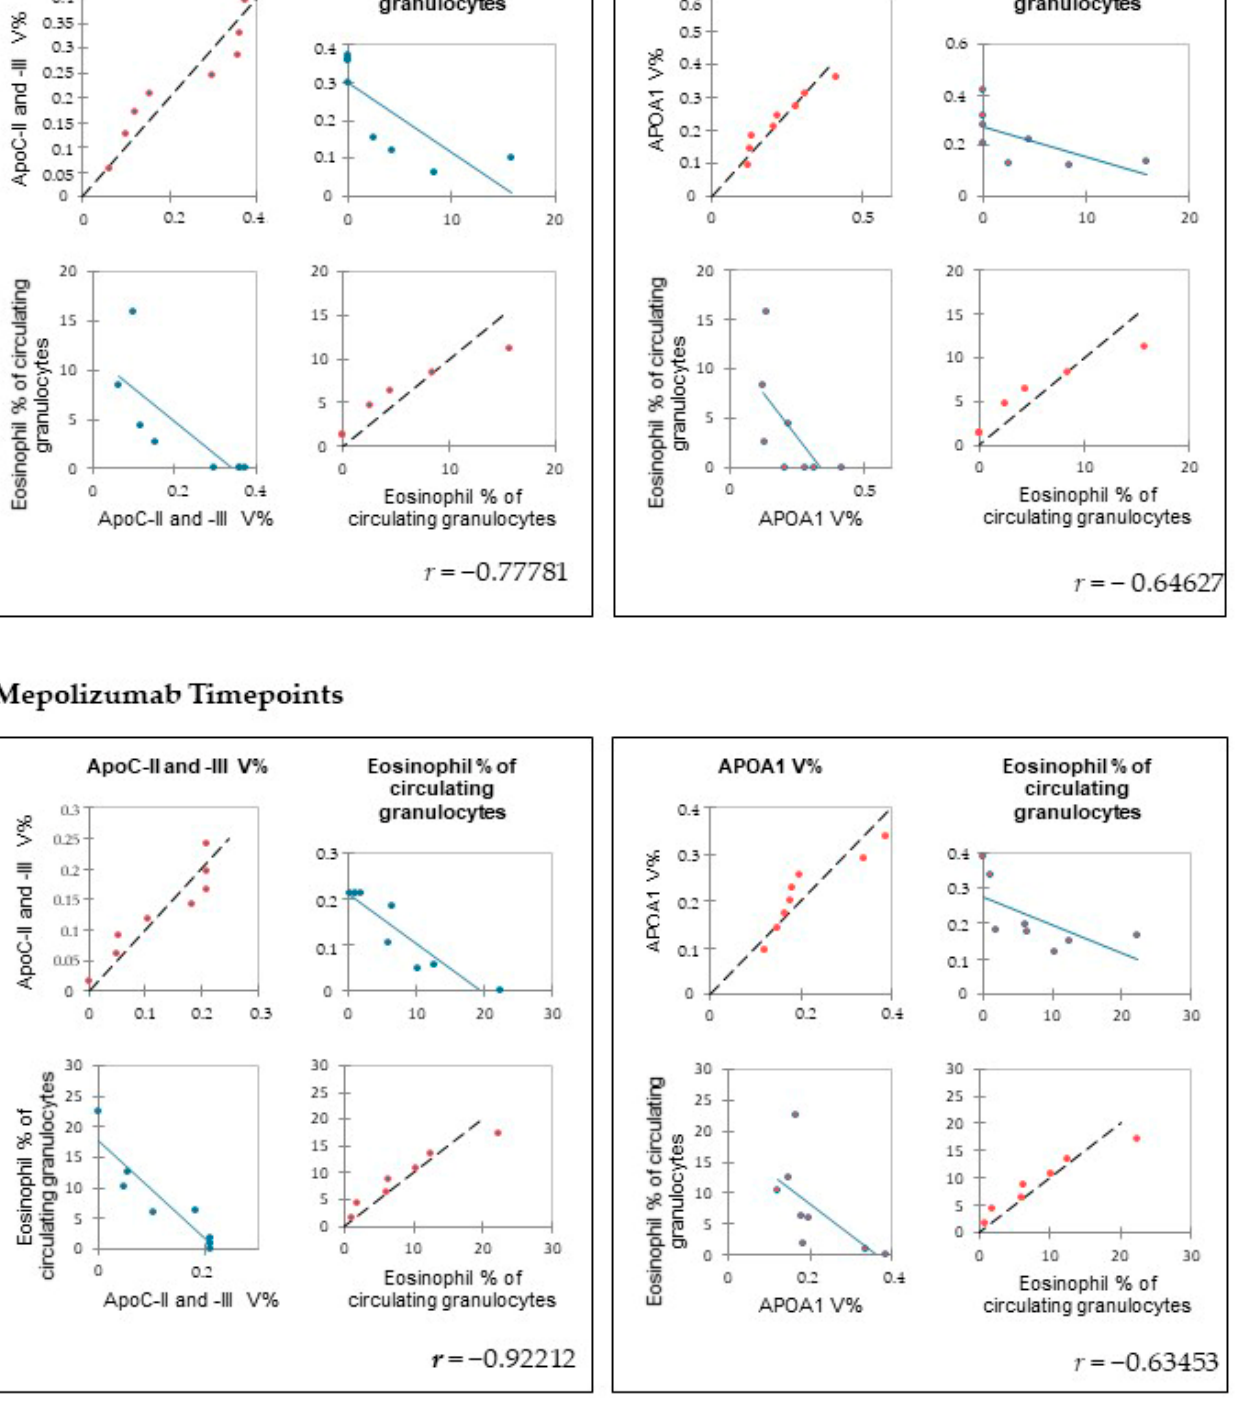
Figure 4. Pearson’s correlation between eosinophil % of circulating granulocytes in SEA patients and APOA1, APOC-II, and -III %V in serum at T0 and T6 time points. Values are shown with Pearson’s correlation coefficients ® .